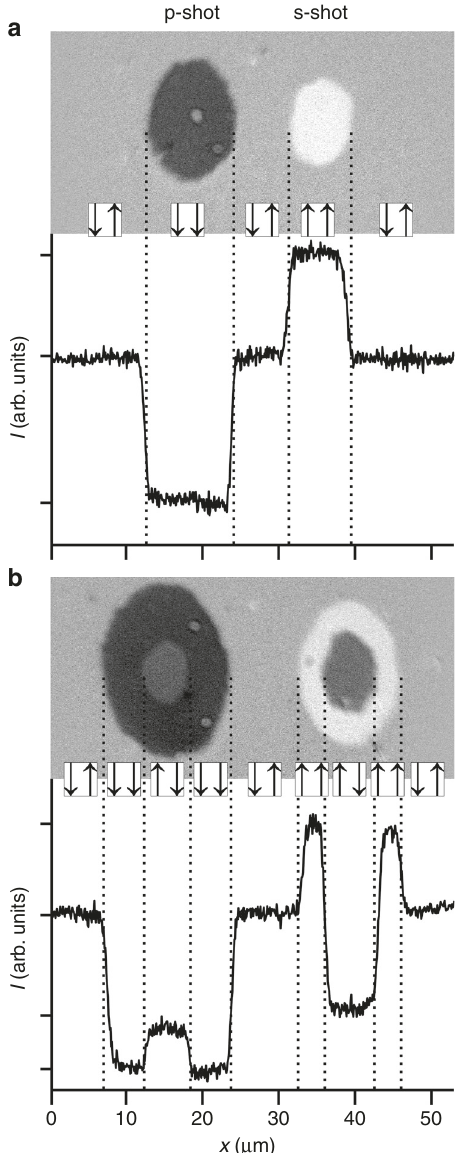
Fig. 3 Polarization-dependent all-optical switching of magnetization in different layers of the heterostructure. Background-corrected magneto- optical images are shown, taken after exposing the heterostructure to a single p-polarized (left spot) and s-polarized (right spot) optical pulse, incident at an angle of 59°. Also shown is a cross-section (averaged over a width of 1.8 µ m) extracted from the image. The left (right) arrow indicates the orientation of the magnetization of Gd within the top (bottom) layer of GdFeCo. The results shown in a and b were obtained with an incident fl uence of ∼ 10 mJ/cm 2 and ∼ 12 mJ/cm 2